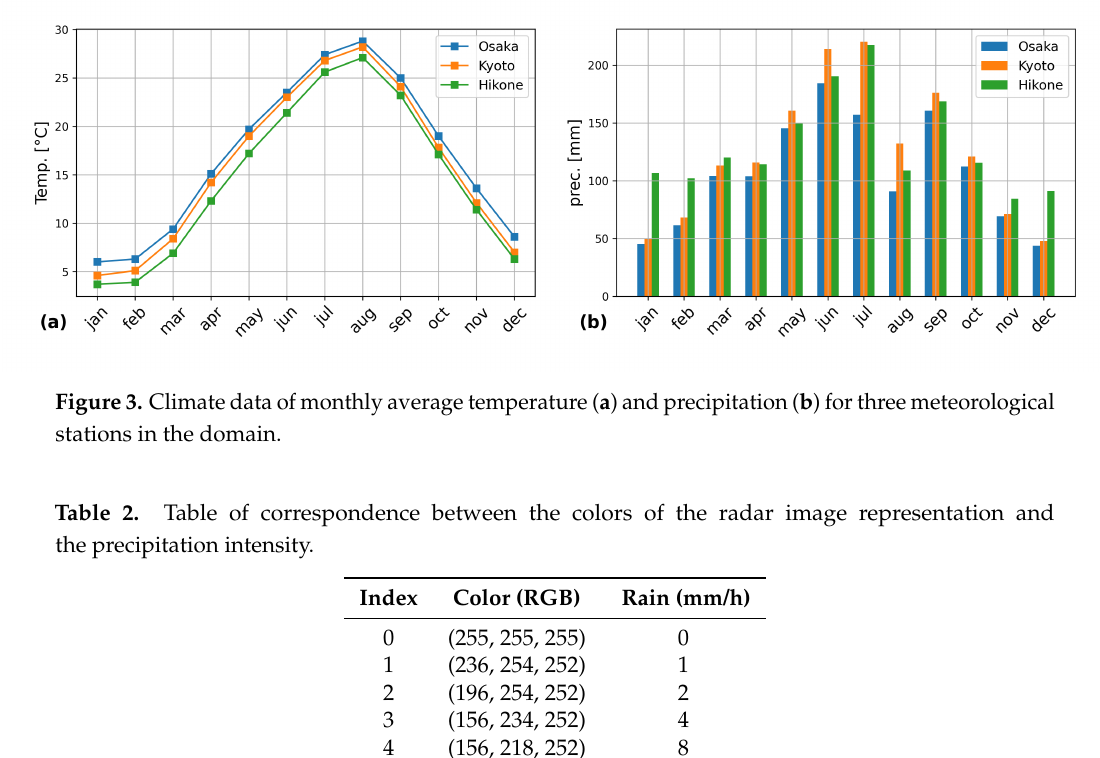
Figure 2. On the left the map of Japan in which is highlighted the area shown in detail on the right that represents the domain covered by the Japanese meteorological radar whose data is used in this work.